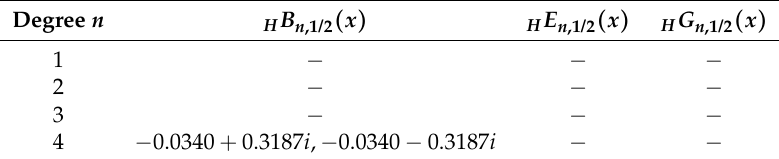
Table 8. Complex zeros of H B n ,1/2 ( x ) , H E n ,1/2 ( x ) and H G n ,1/2 ( x )